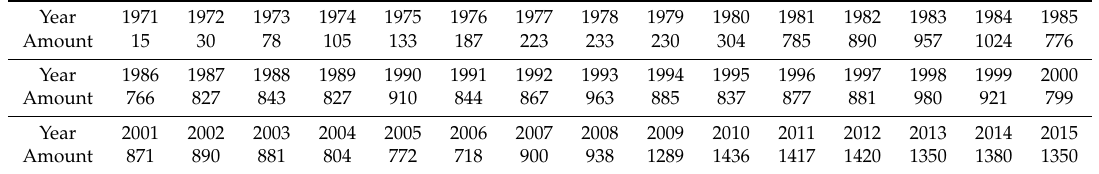
Table 3. Statistical table of thermal ground water exploitation in the study area (unit: 10,000 m 3